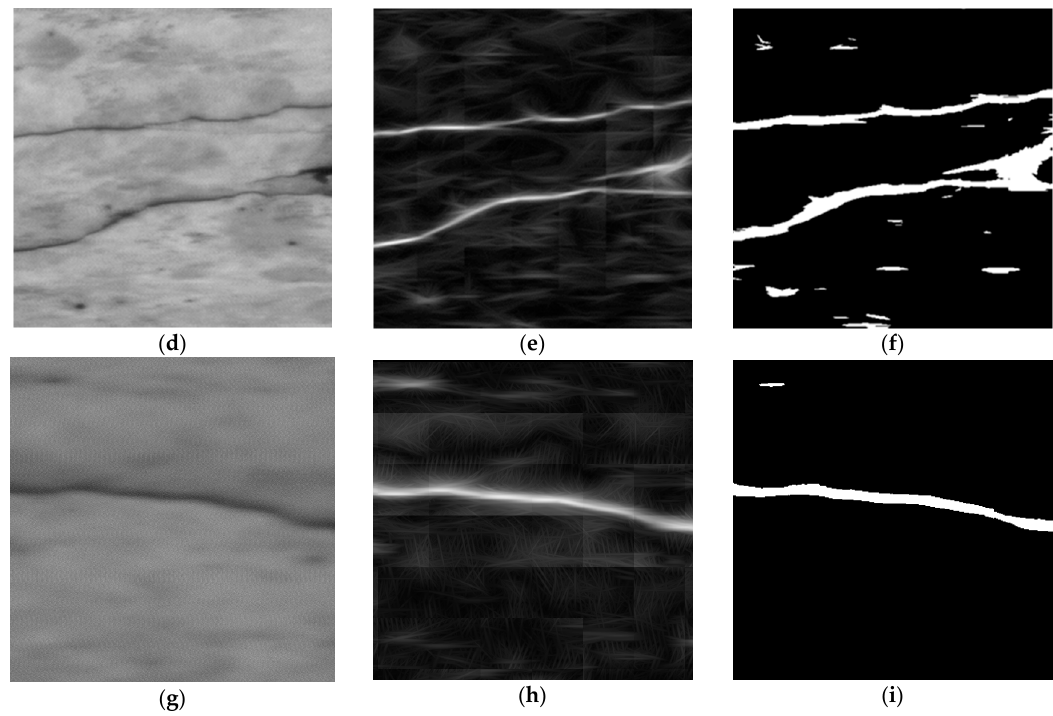
Figure 7. Example of application of the rotation-invariant Gabor filter. ( a , d , g ) are the normalized original images. ( b , e , h ) are the filtered images; ( c , f,i ) the segmented images.